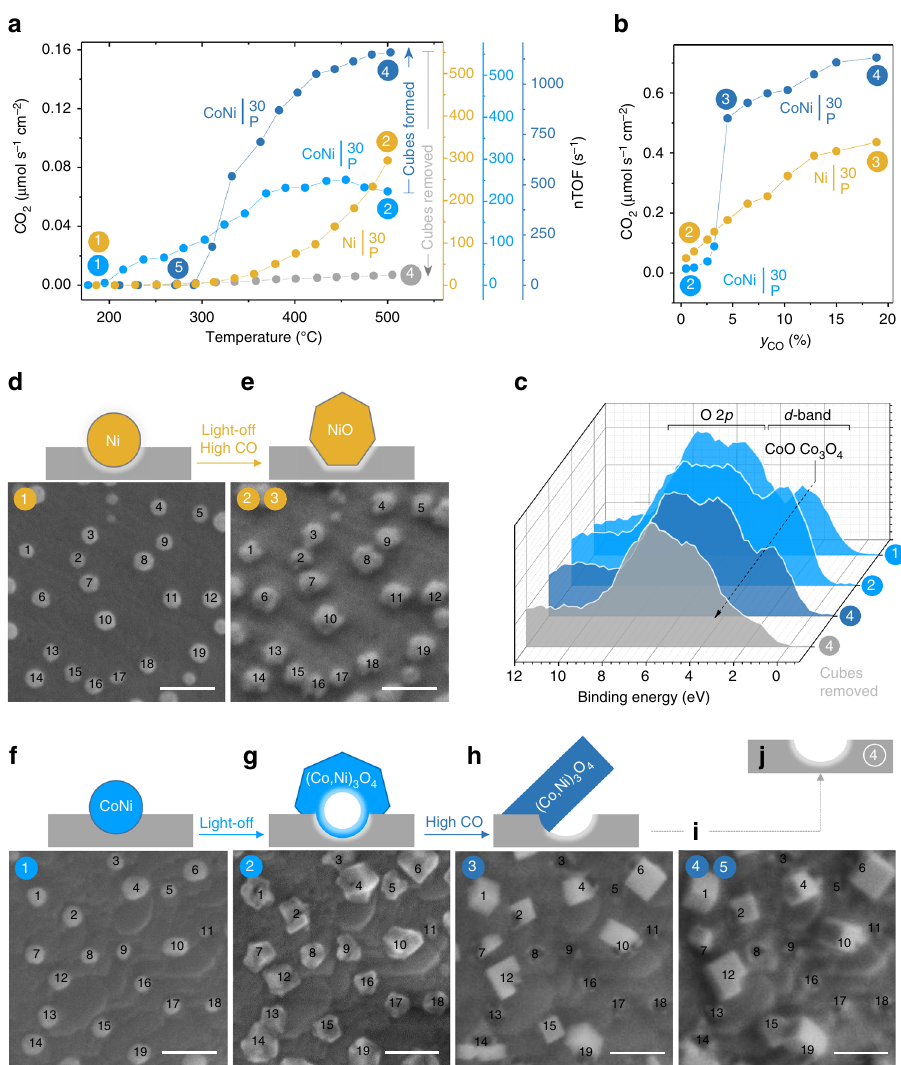
(dark-yellow) and CoNi j 30 (light-blue prior to Fig. 2 Restructuring and catalytic activation at con fi ned particles. Highlighted systems include: Ni j 30 P P restructuring and dark-blue after). a CO 2 production rate from CO oxidation, as a function of temperature, using the indicated model (pellet) catalysts. The rate on the left y -axis is normalised with respect to the area of the pellet surface decorated with particles (Supplementary Note 1). The colour circled numbers highlight the sequence in which the catalytic experiments were carried out and also the stages at which particle tracking or XPS measurements were conducted. The right y -axis shows corresponding nTOF values as a function of temperature (Supplementary Note 3 for details). Errors are of the size of the points used for plotting. b CO 2 production rate as a function of CO mole fraction, at 520 °C, for the samples used in the experiments shown in a . c XPS valence band spectra, guideline showing evolution of Co 3 O 4 phase across selected samples (signal assignment based on ref. 42 ). d – i SEM micrographs (scale bars, 100 nm) of tracked areas collected at room temperature at the highlighted stages of catalytic testing, and corresponding